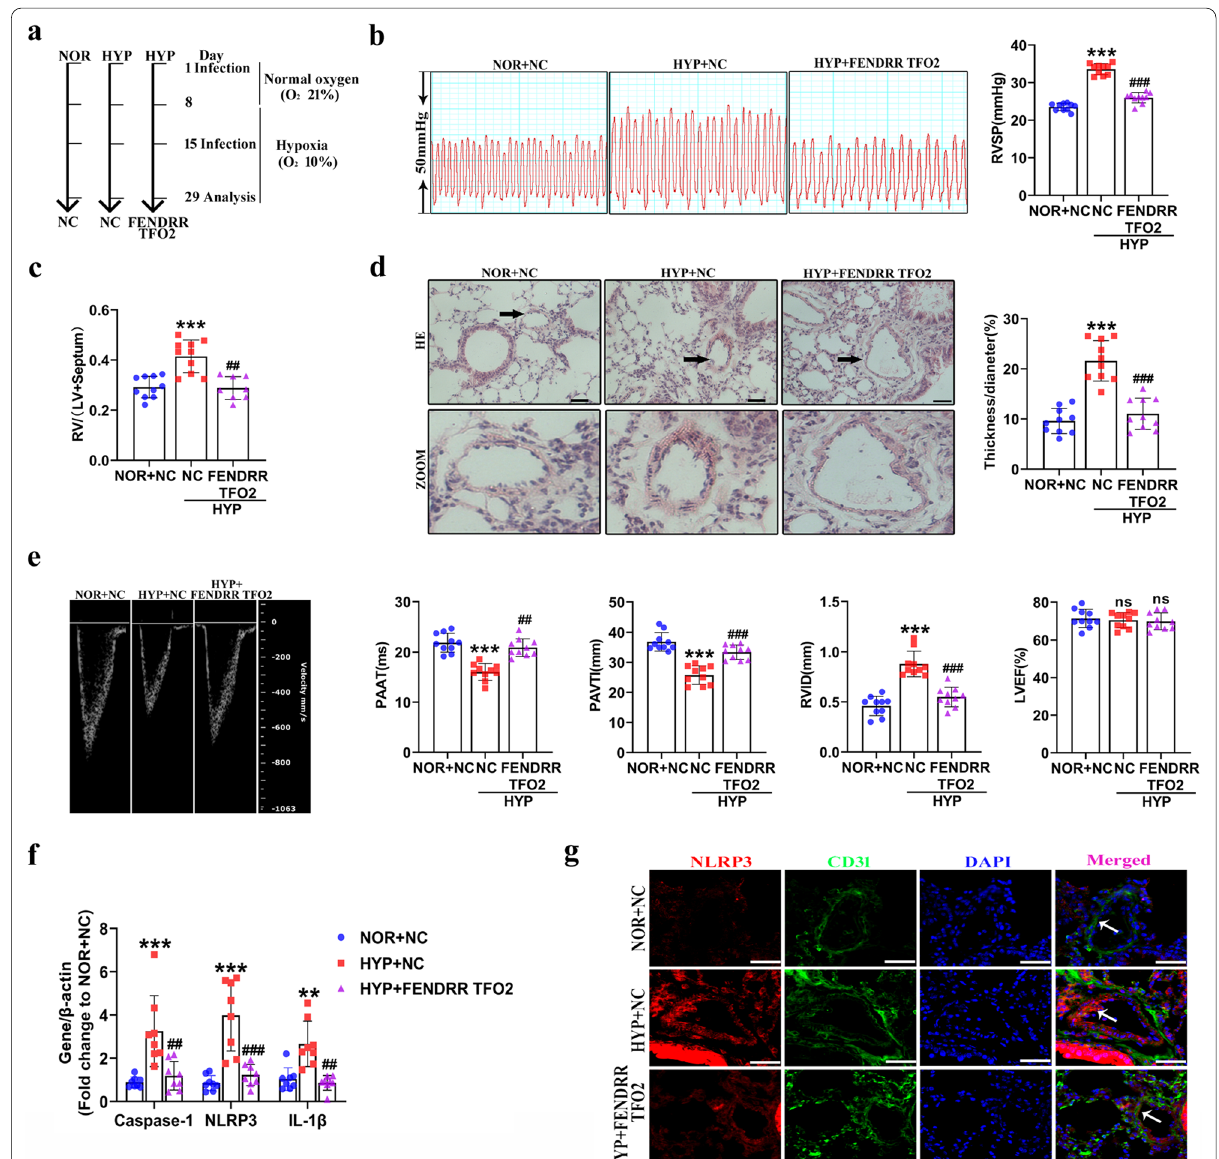
Fig. 7 Overexpression conserved sequence TFO2 adenovirus of FENDRR in vivo alleviates the development of HPH and inhibits hypoxia-induced pyroptosis. a Adenoviruses with NC or TFO2 sequences were used to handle mice via dropwise intranasal instillation to mice and subjected to hypoxia until 29 days. b Indices of Right ventricular systolic pressure (RVSP) (n 10). c Right ventricle (RV)/(left ventricle (LV) Septum) weight = + ratio was calculated (n 10). d HE staining was performed to detect wall thickening (n 10). e Echocardiographic images and indexes (n 10). f = = = qRT–PCR was used to examine the lung tissues mRNA levels of Caspase-1, NLRP3 and IL-1β (n 8). g Immunofluorescence of NLRP3 in mouse lung = sections. Scale bars 50 µm. All values are presented as the mean SD. Statistical analysis was performed with one-way ANOVA. NOR: normoxic; = ± HYP: hypoxic; NC: negative control; ns: no significant. *P < 0.05, **P < 0.01, ***P < 0.001 compared with